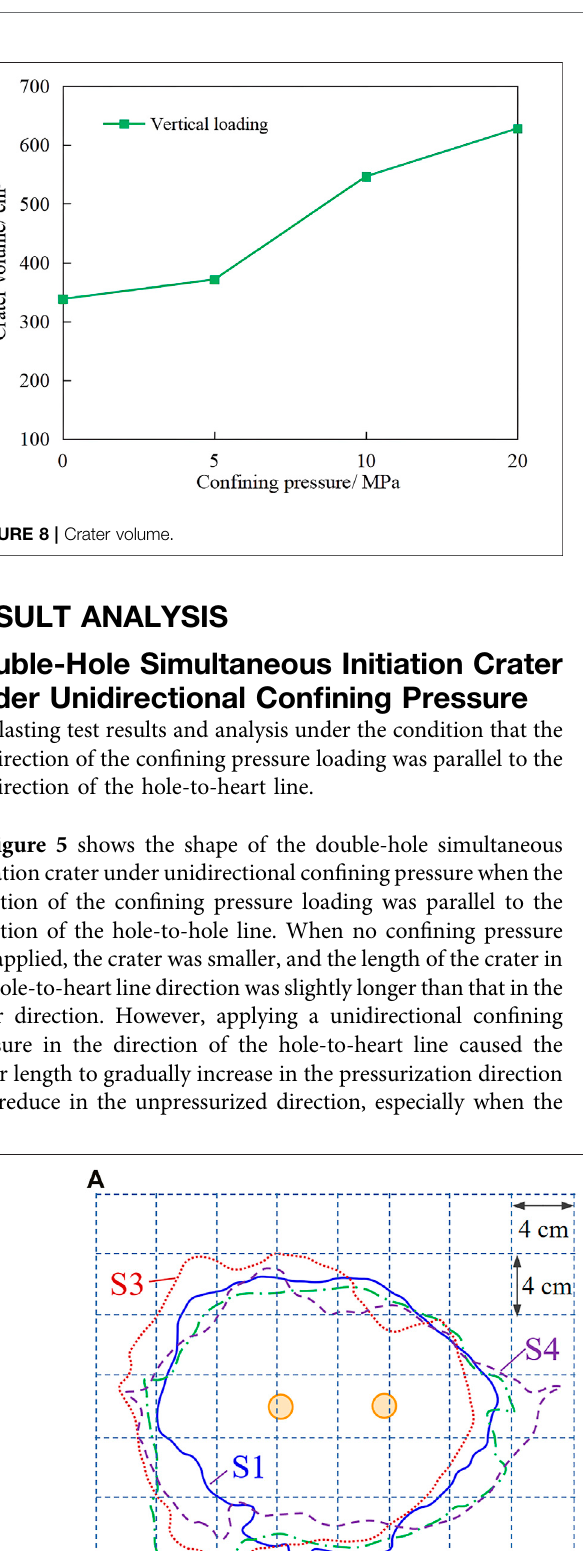
Frontiers in Earth Science |